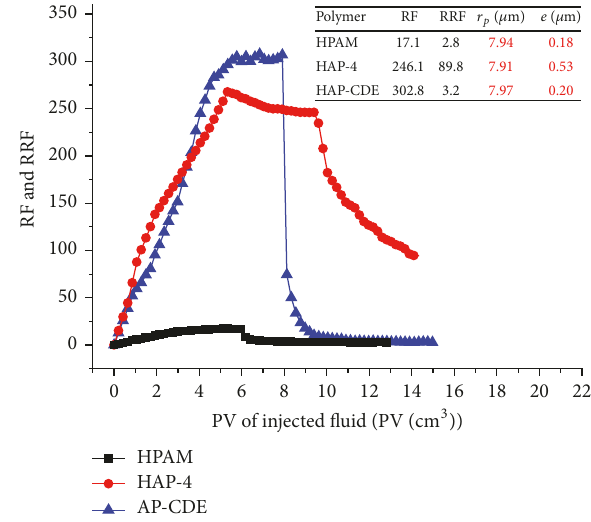
Figure 7: RF and RRF as a function of PV of the polymer slugs (0.2 wt%, ̇𝛾 = 7.34 s −1